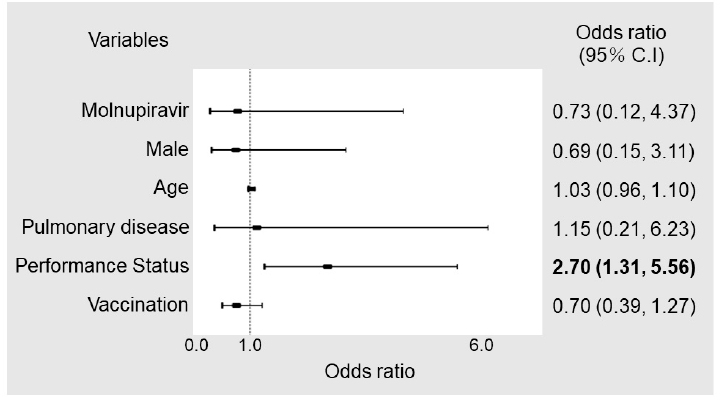
Figure 1. Cumulative hospitalization rate according to the drug type.